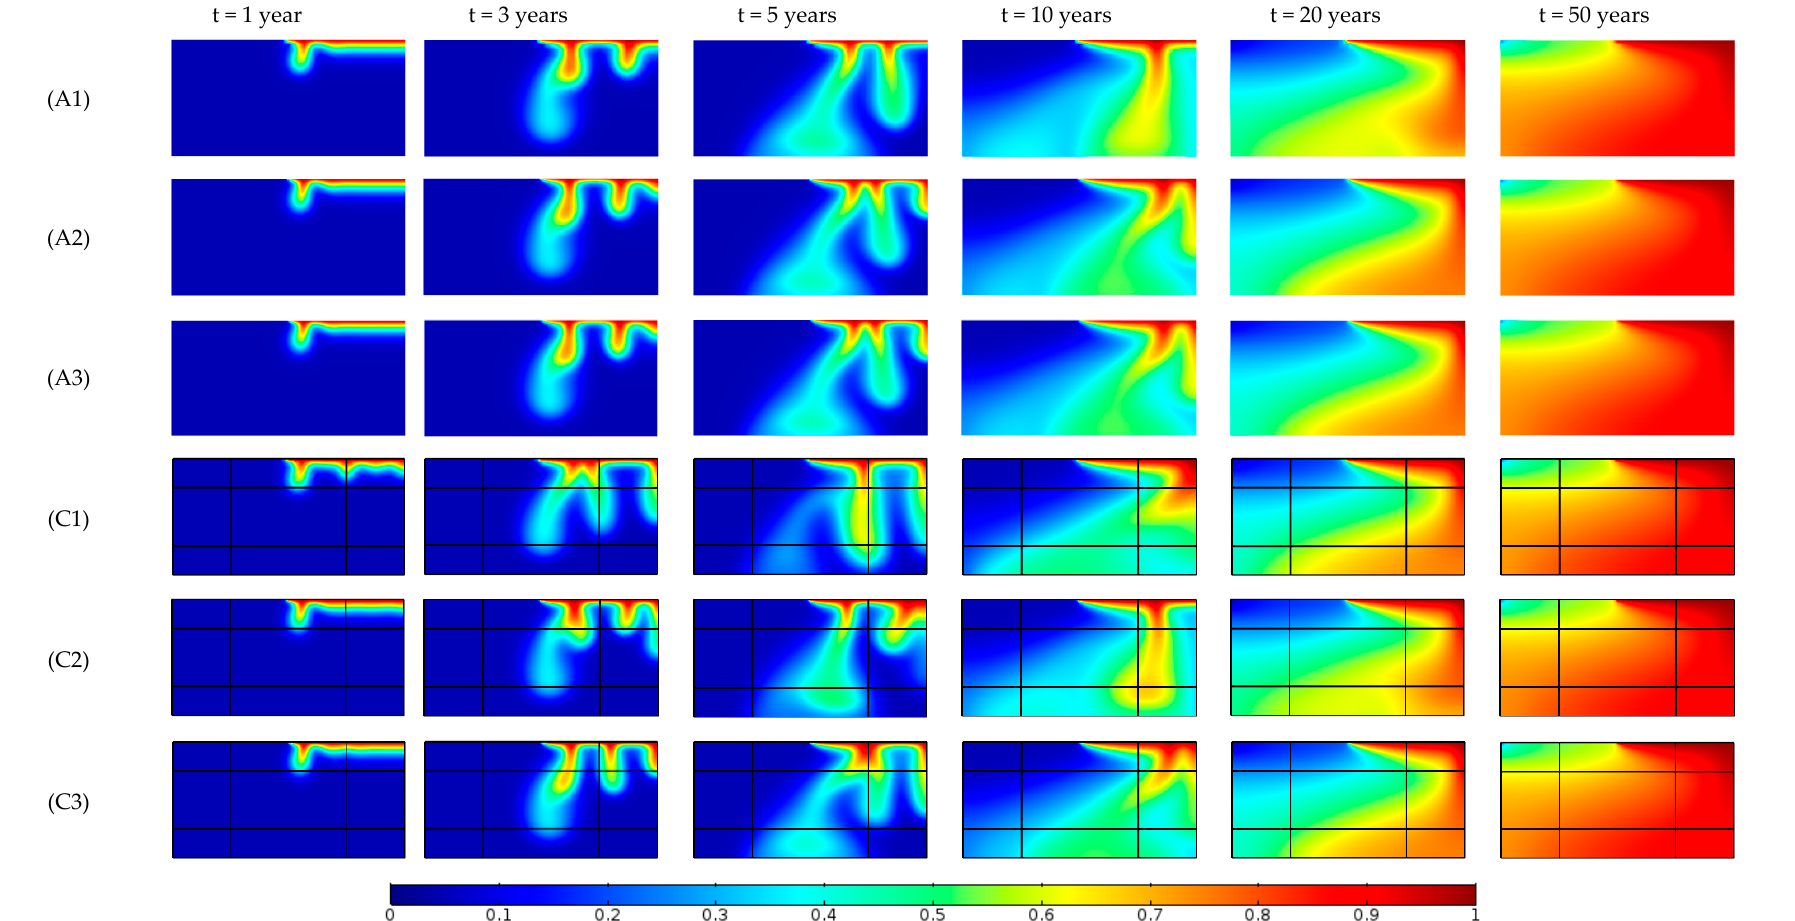
Figure 4. Relative concentration distribution for scenarios (A) and (C) for different levels of mesh refinement: (A1), (A2) and (A3) correspond to grids with 2509, 10,235 and 90,973 triangular elements respectively. (C1), (C2) and (C3) correspond to grids with 2671, 1,0565 and 9,1875 triangular elements respectively.